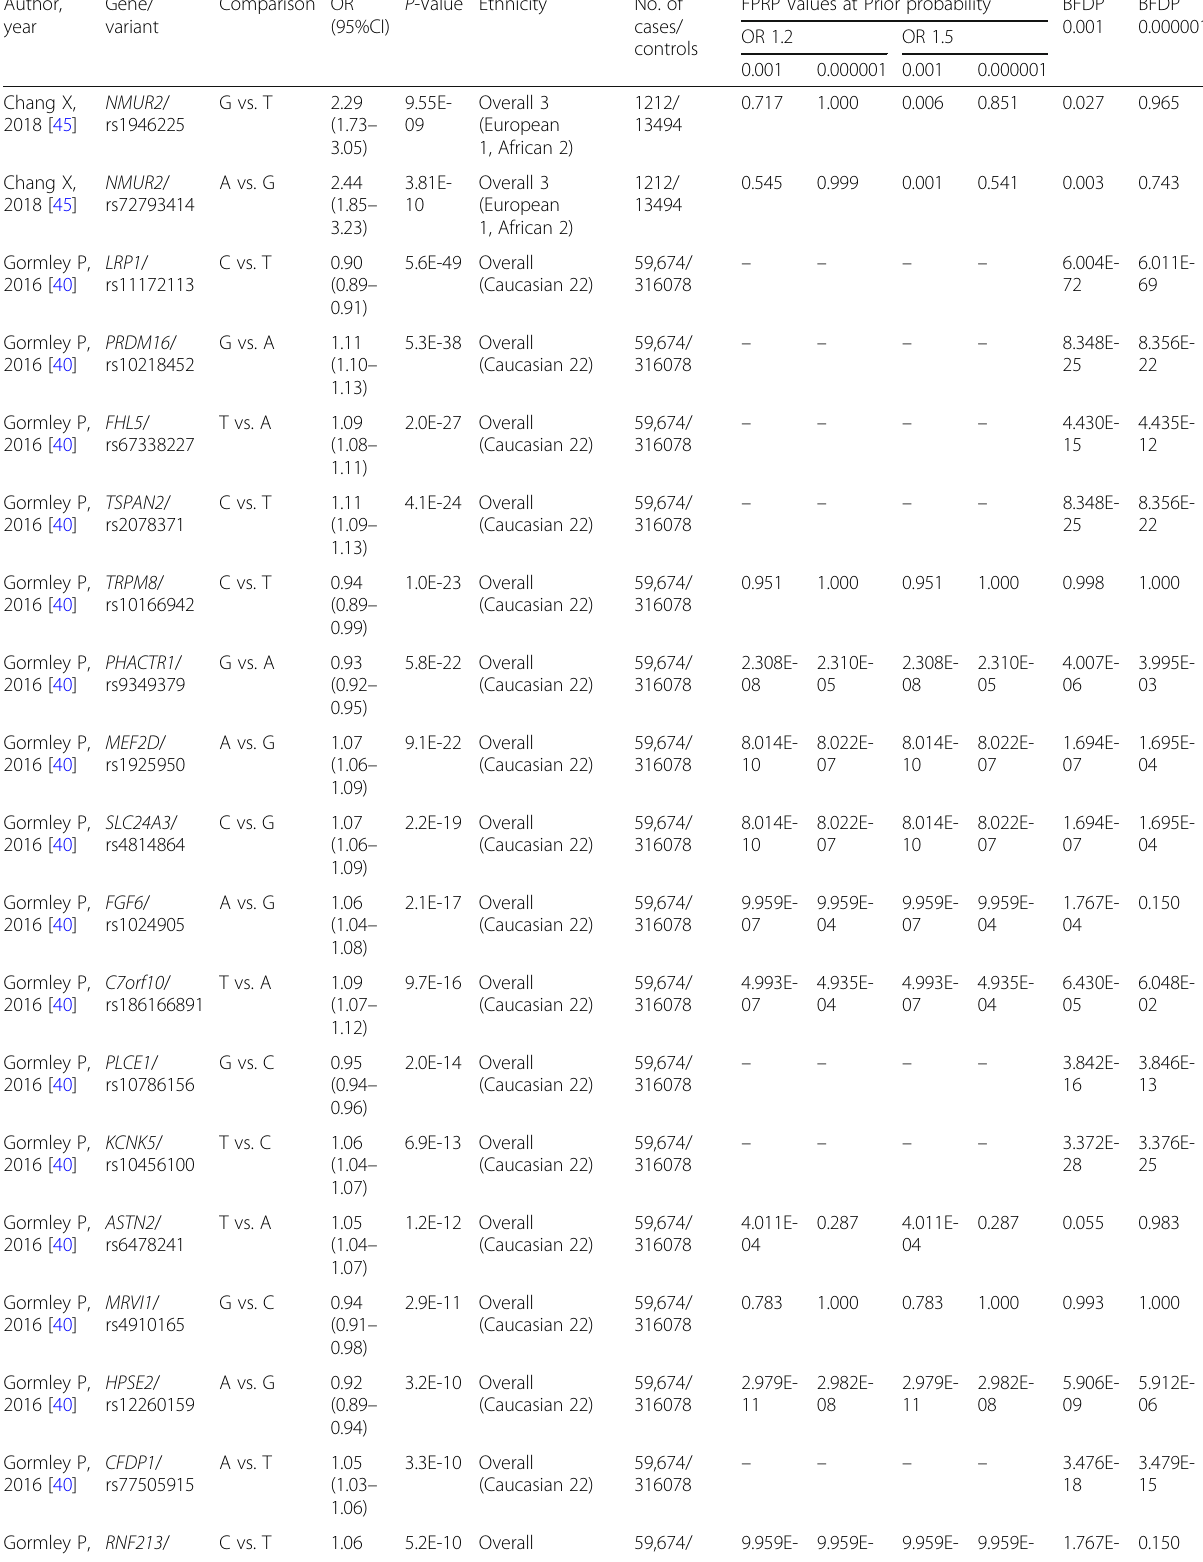
Table 2 Meta-analyses results of genetic variants with statistically significance ( P -value< 5*10 − 8 ) from